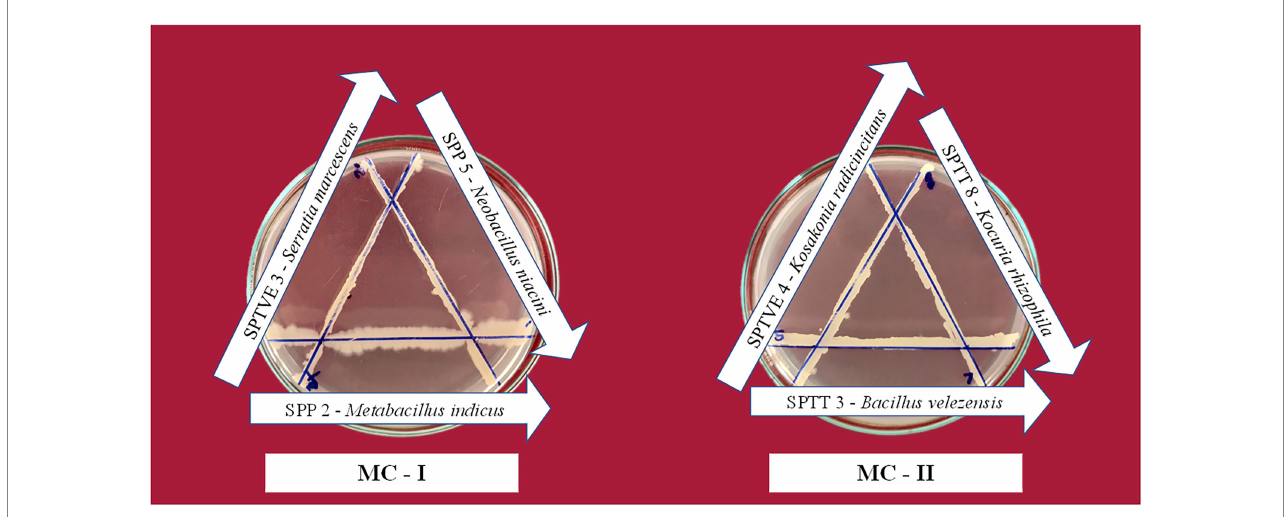
FIGURE 4 Compatibility assay between the bacterial isolates in the halotolerant microbial consortia. The lack of inhibition zone between two streaks indicate compatibility.